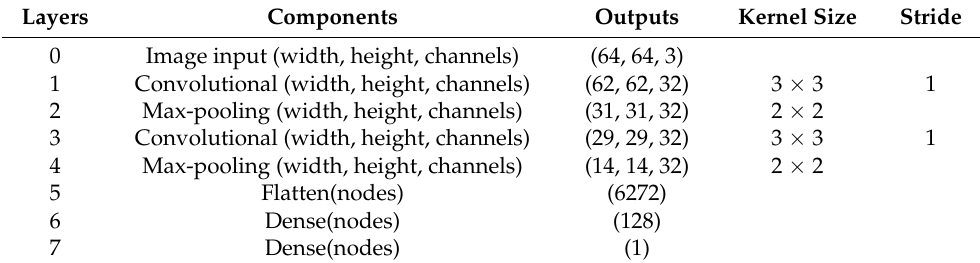
Figure 2. The architecture of CNN used in this study. Table 3. The illustration of components in the proposed CNN